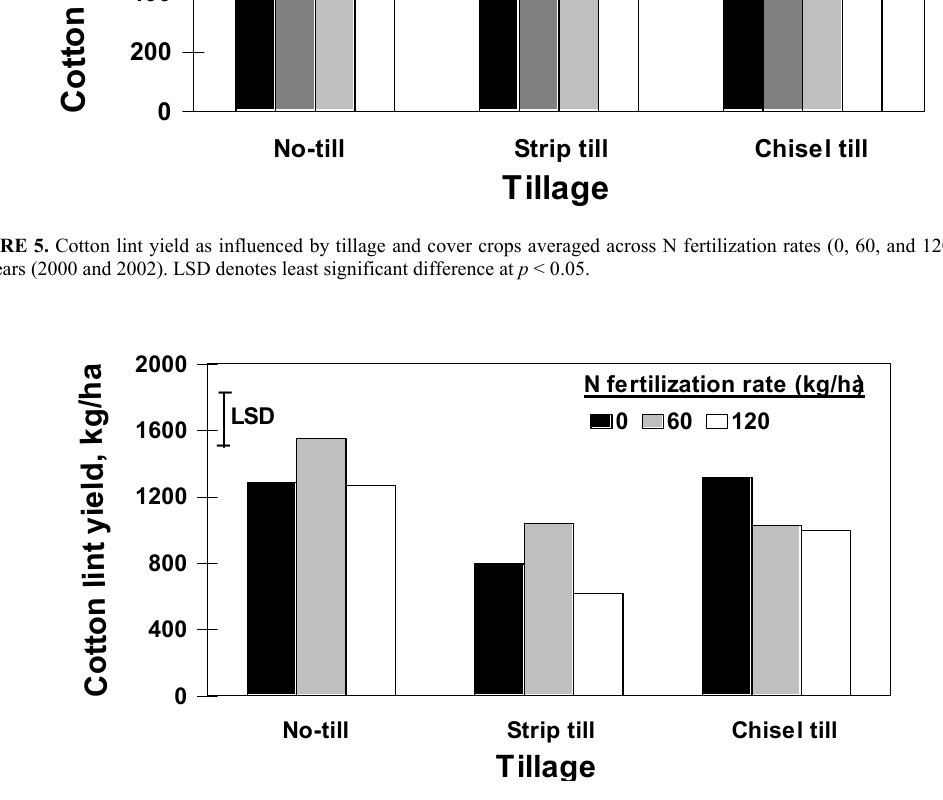
FIGURE 6. Cotton lint yield as influenced by tillage and N fertilization rates averaged across cover crops (rye, hairy vetch, rye + hairy vetch mixture and no cover crop) in 2000. LSD denotes least significant difference at p <